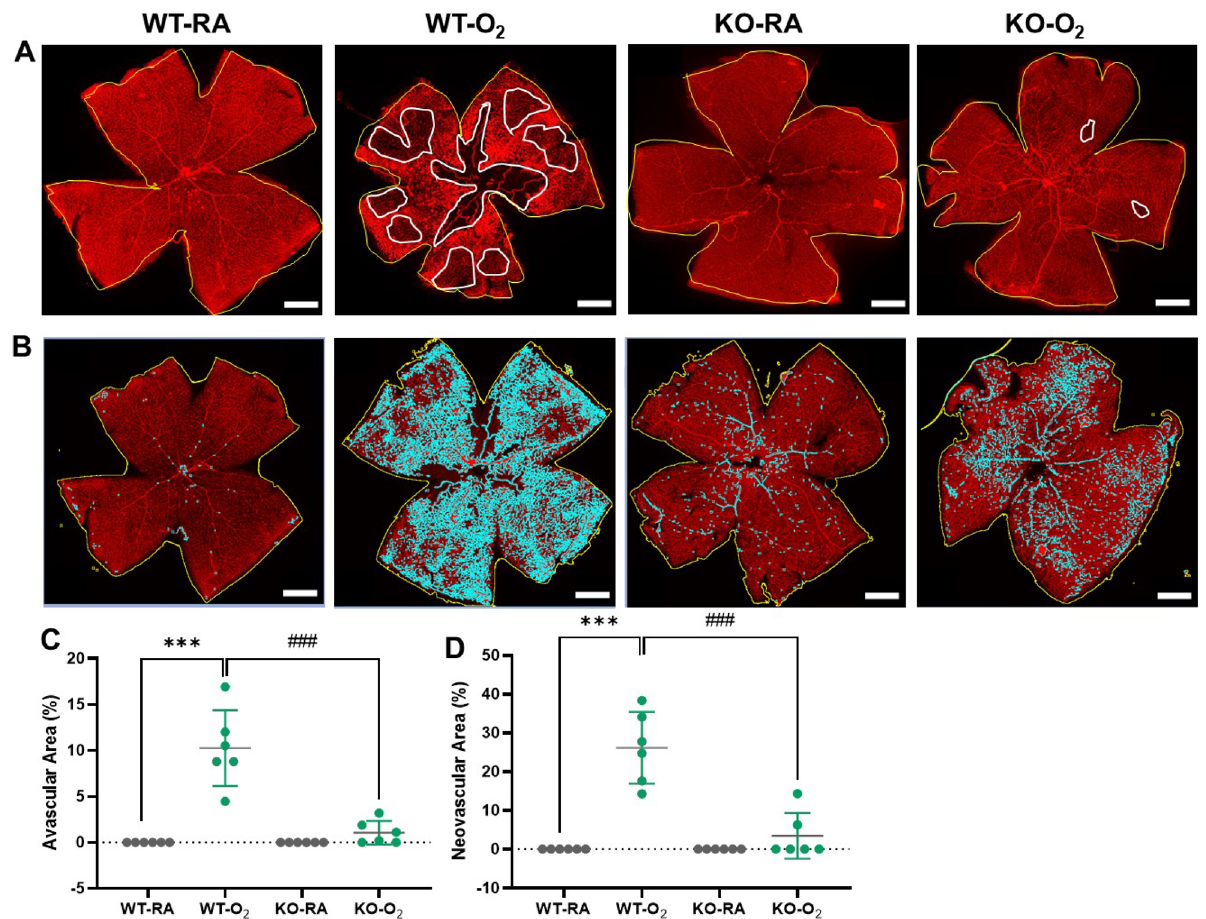
Figure 7. GSDMD deficiency prevents hyperoxia-induced retinal vasoobliteration and neovascularization. Immunofluorescent staining for isolectin (red signals) was used to identify retinal vessels. ( A ) The total retina area and total avascular area were outlined in yellow and white, respectively. ( B ) The total retinal area was outlined in yellow and total neovascular area was measured via isolectin intensity (cyan signals). ( C ) Quantification of the percentage of the avascular area (avascular area divided by total retinal area) showed that retinas from hyperoxia-exposed WT mice had markedly increased vasoobliteration. In contrast, GSDMD-KO mouse retinas had minimal vasoobliteration after hyperoxia exposure. ( D ) Quantification of the percentage of the neovascular area (neovascular area divided by total retinal area) demonstrated that retinas from hyperoxia- exposed WT mice had greatly increased neovascularization, but GSDMD-KO mouse retinas had comparatively little neovascularization when exposed to hyperoxia. n = 6/group. *** P < 0.001, WT-RA vs WT-O 2. ### P < 0.001, WT-O 2 vs KO-O 2. 5 × magnification. Scale bars: 50 of the thickness of each specified layer. Overall retinal thinning in the WT hyperoxia group compared to the WT-RA group can be appreciated in the shown histology (Fig. 8A). We found that the GSDMD-KO group had overall decreased retinal thinning compared to the WT hyperoxia group, particularly seen in the outer plexiform (Fig. 8B), inner plexiform (Fig. 8C) and inner nuclear layers (Fig. 8D). There is also significant ablation of the ganglion cell layer in the WT-O 2 group as seen in Fig. 8A (data not quantitated). Knockout of GSDMD reduces hyperoxia‑induced retinal inflammation. We next examined the retinas for inflammation by immunofluorescent staining for allograft inflammatory factor-1 (AIF), a marker of microglia activation 21 . In hyperoxia-exposed WT retinas, there were increased numbers of activated microglia cells that had a reduction in the territory, enlargement of the cell body, and a more irregular cell shape as well as a self-association for each other (Fig. 9A,B). In contrast, the retinas from the other three groups had fewer microglia cells which had small cell bodies, and few dendrites and were evenly disbursed throughout the retinas. Furthermore, when AIF1 stained sections were dual stained with isolectin, we found abundant activated micro- glia cells in areas of vasoobliteration and neovascularization (Fig. 9C,D). These results highlight that GSDMD- KO prevents hyperoxia-induced retinal inflammation. GSDMD deficiency reduces hyperoxia modulation of inflammatory, cell death, and vascular and visual developmental gene pathways in the neonatal retinas. To better characterize the